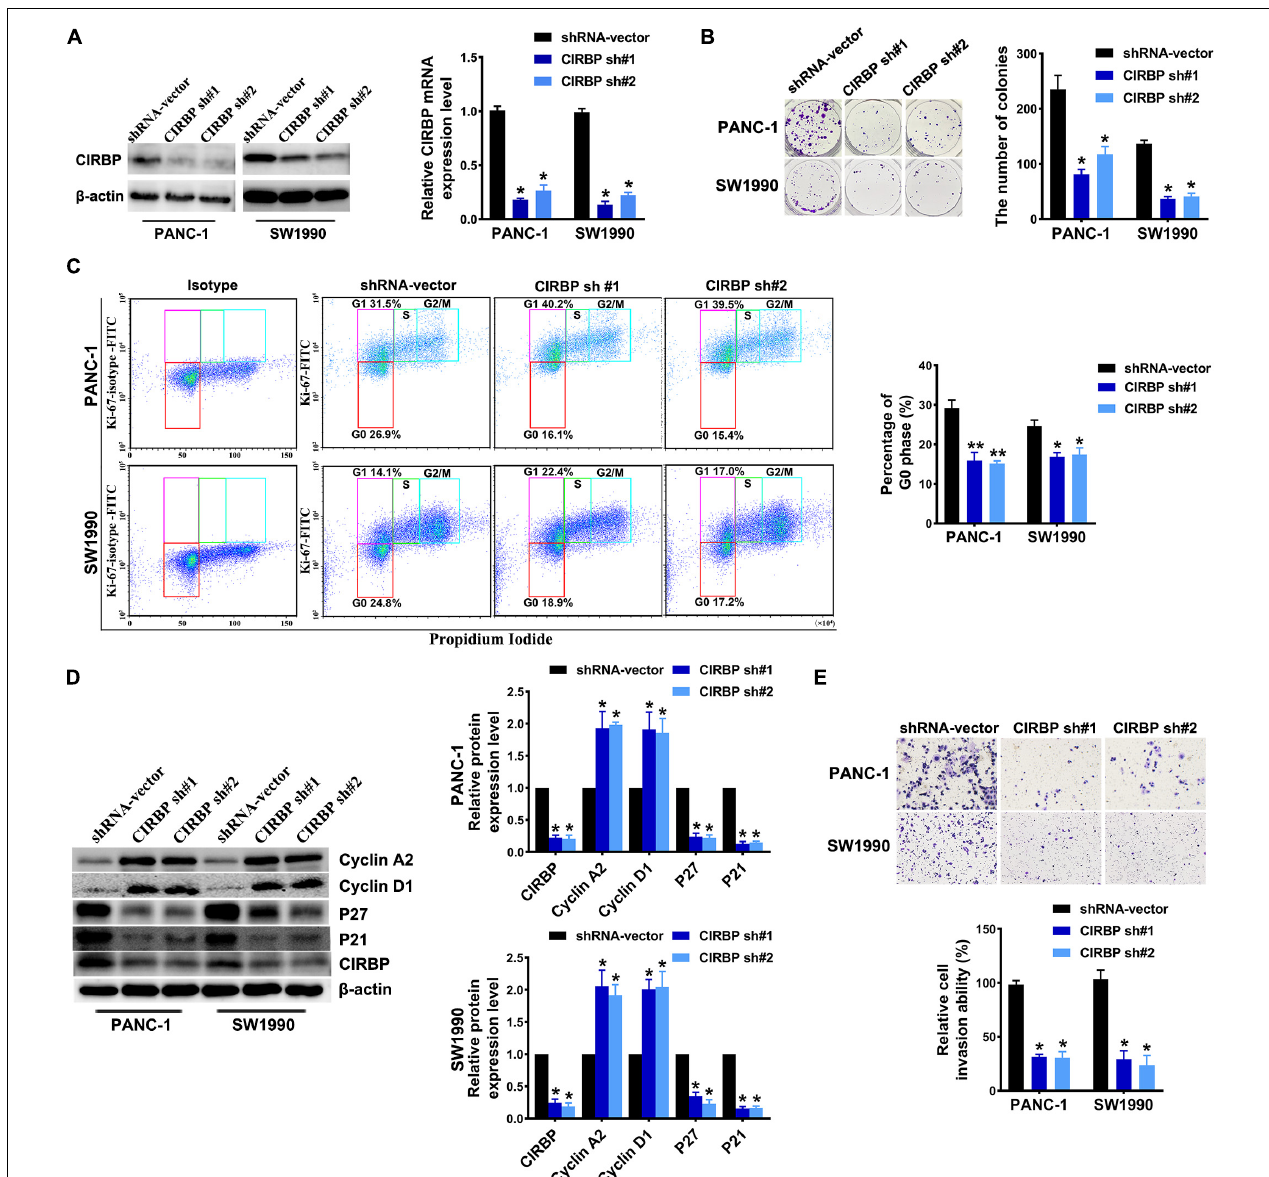
FIGURE 2 | CIRBP knockdown inhibits the invasion and cell cycle of pancreatic cancer cells in vitro . (A) The interference efficiency of the lentiviral human CIRBP-targeting short hairpin RNA (shRNA) was validated by Western blot and RT-qPCR analysis. (B) The effects of CIRBP knockdown on the colony formation of pancreatic cancer cells. (C) Cell cycle of PANC-1 and SW1990 cells with CIRBP knockdown was analyzed by Ki-67 and propidium iodide stainings. Ki-67 antigen is rarely detected in G0 phase, but highly expressed in the proliferating cells (G1, S, G2, and M phases). G0 (red, lower boxes) and G1 (purple, upper left boxes) cells exhibit 2N DNA, S phase cells (green) exhibit 2N-4N DNA and G2/M cells (blue) exhibit 4N DNA. The experiments were performed on the same day and the data were analyzed with the same gating. The isotype was used as negative control. (D) Western blot analysis of cyclin D1, cyclin A2, p27 and p21 in CIRBP knockdown PANC-1 and SW1990 cells. β -actin was used as a loading control. (E) The invasion of PANC-1 and SW1990 cells with CIRBP knockdown were determined by transwell assays. Data are presented as means ± SD. * P < 0.05, ** P < 0.01, unpaired student’s t